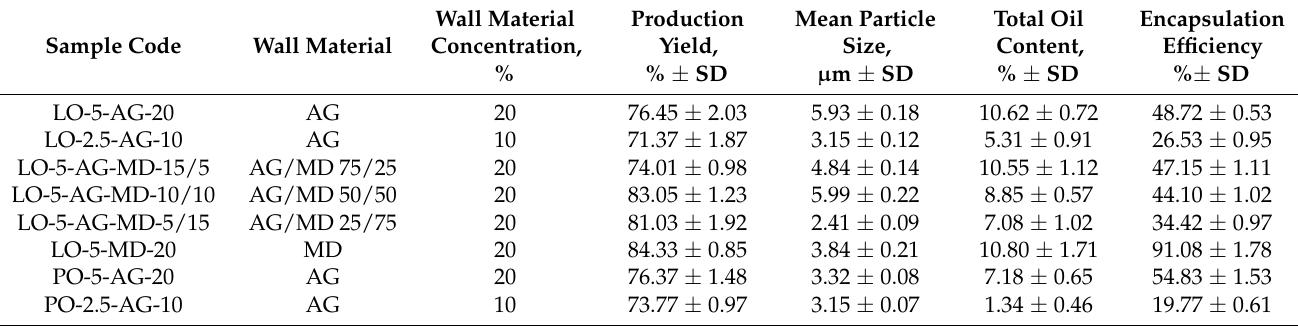
Table 2. Characterization of the microparticles prepared at varied wall material type and concentration (LO = lavender oil, PO = peppermint oil, AG = Arabic gum, MD = maltodextrin; n = 3).